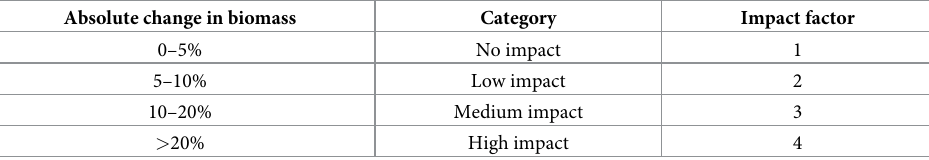
Table 3. Categories of runs according to the absolute change in biomass compared to the control run. Absolute change in